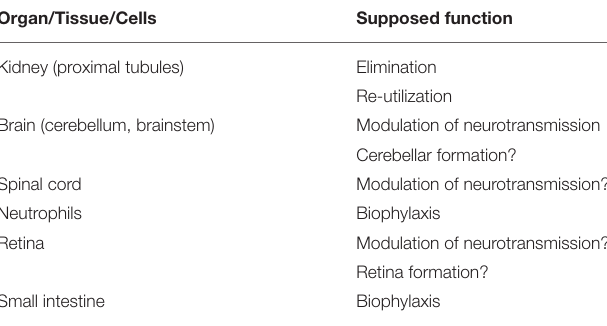
TABLE 1 | Distribution and supposed functions of mouse